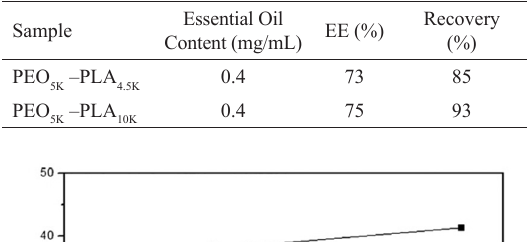
- b -PLA ; (●) PEO - b -PLA 5KDa 10KDa 5KDa 4.5KDa